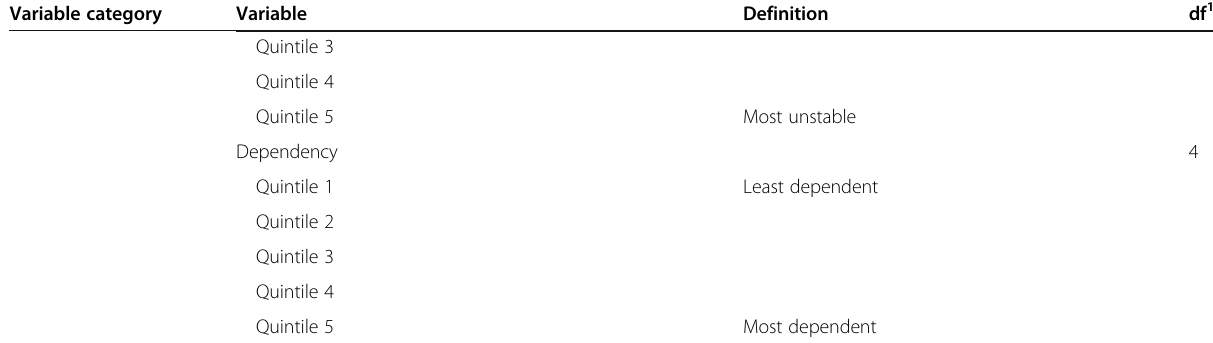
Table 1 Pre-specification of PreMPoRT predictive variables (Continued) Variable